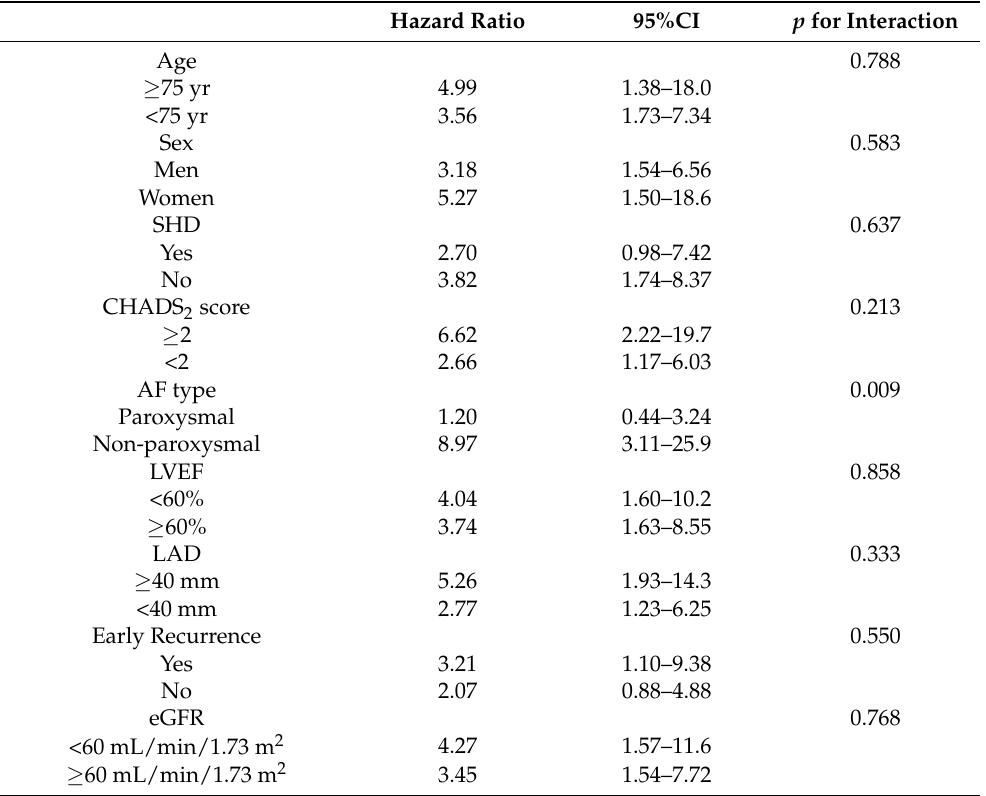
Table 5. Subgroup analysis of arrhythmia